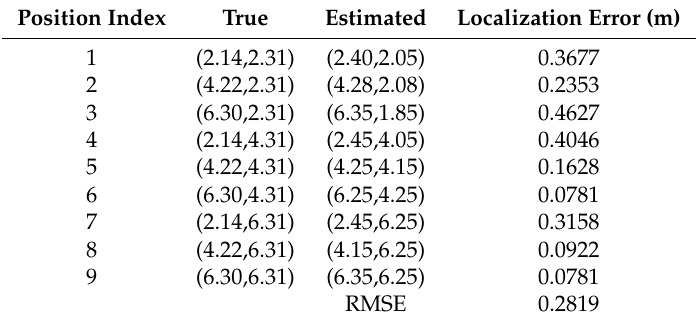
Figure 11. The heatmap of likelihood value for GML at the 9 test positions. Table 1. Localization Results of RTI.